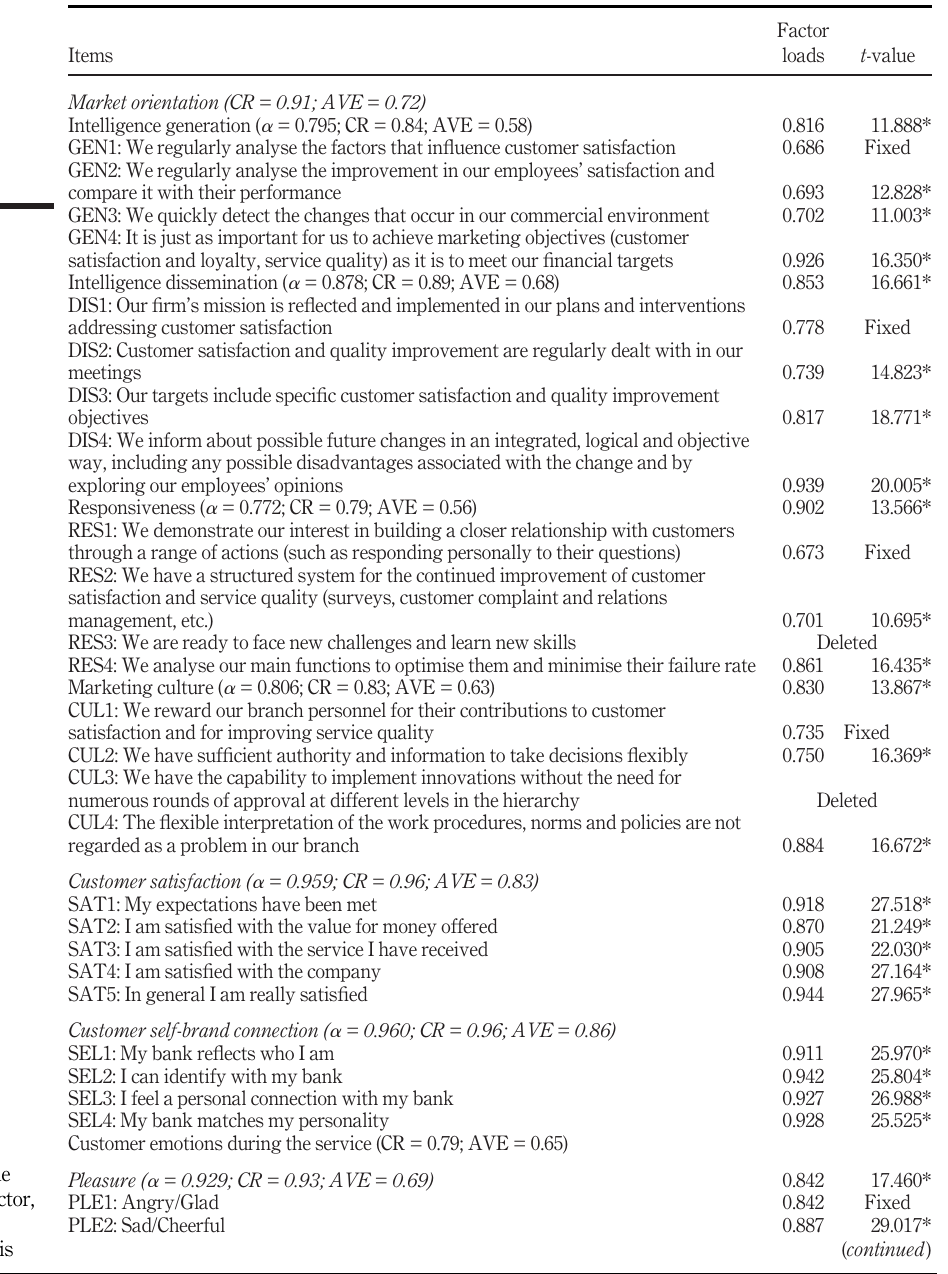
Table IV. Summary of the results after factor, reliability and validity